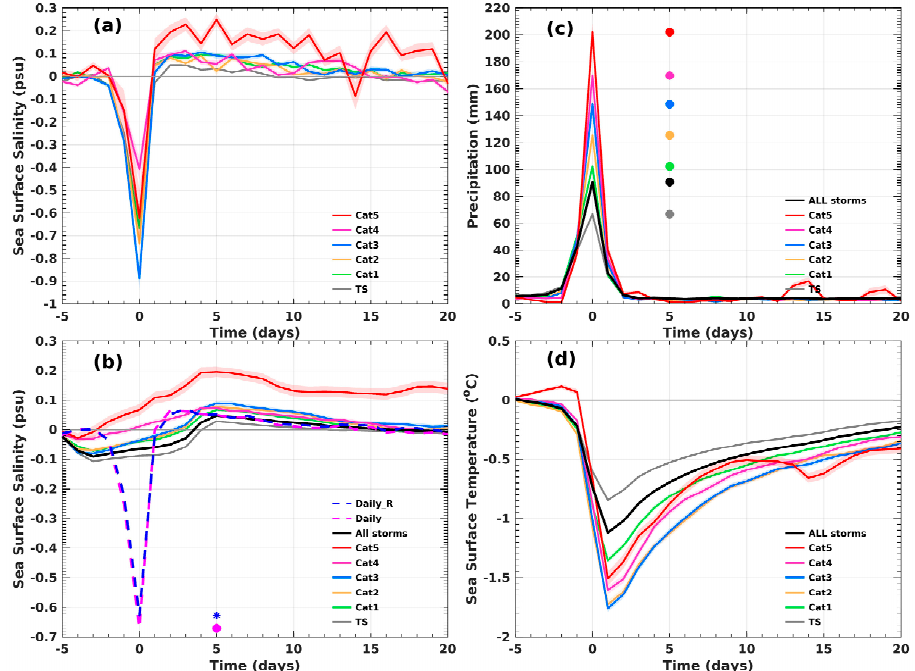
Figure 2. Lagrangian composites relative to TC passage for: ( a ) daily SSS, ( b ) eight-day running mean SSS, ( c ) daily precipitation and ( d ) daily SST. Panel ( a ) shows SSS anomaly relative to the reference SSS for the composite average of different intensity categories during the period 2015–2019, from SMAP swath daily raw data (L2C). Panel ( b ) is as in ( a ) but using SMAP eight-day running mean data (L3). The dashed blue (purple) line is calculated using SMAP swath daily data with (without) the high surface wind (>15 m s − 1 ) associated SSS removed. The blue and purple dots indicate the maximum negative SSS anomaly for the composite average of all storms with and without the high surface wind associated SSS removed, respectively. Panel ( c ) shows composite daily accumulated precipitation during the same period with ( a ). The corresponding dots are the accumulated precipitation on day 0 for different categories. Panel ( d ) shows composite SST anomaly response relative to the reference SST during the same period with ( a ). The composited variables are averaged over a 2 ◦ × 2 ◦ region centered over TC track positions from days − 20 to 20. Color shading indicates the standard error of each